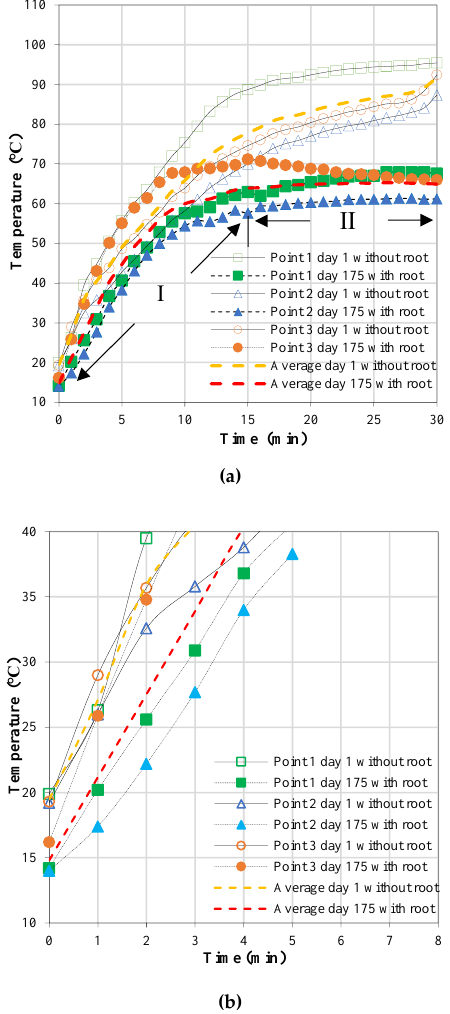
Figure 6. The heating efficiency of the substrate with and without plant roots at different monitoring points. ( a ) The variation of temperatures with the increase of time; ( b ) the heating efficiency of substrate below 40 ° C.